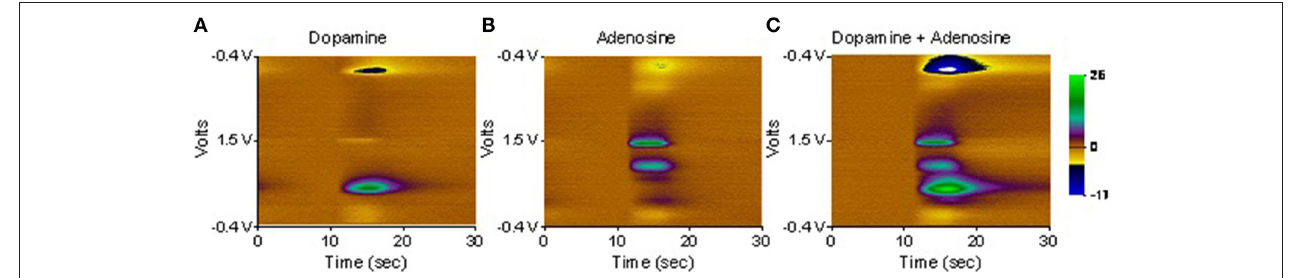
FIGURE 2 | Diamond FSCV probe exposed to dopamine at 2.5 µ M (A), adenosine at 20 µ M (B), and dopamine + adenosine at the same concentrations (C). Note that the signals of the two neurotransmitters occur at different voltages and are effectively additive. That is, the voltammogram of dopamine + adenosine is a linear combination of the voltammograms of the two individual